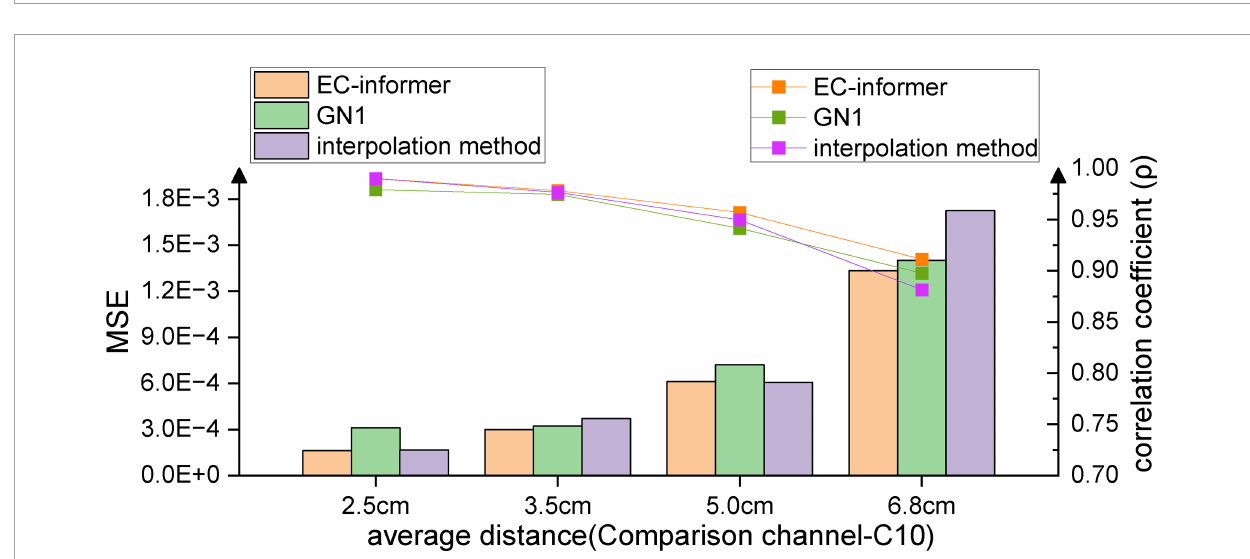
FIGURE7 As the distance from the target channel increases, the complementary effects of all three methods decrease, but overall, EC-informer has the best complementary